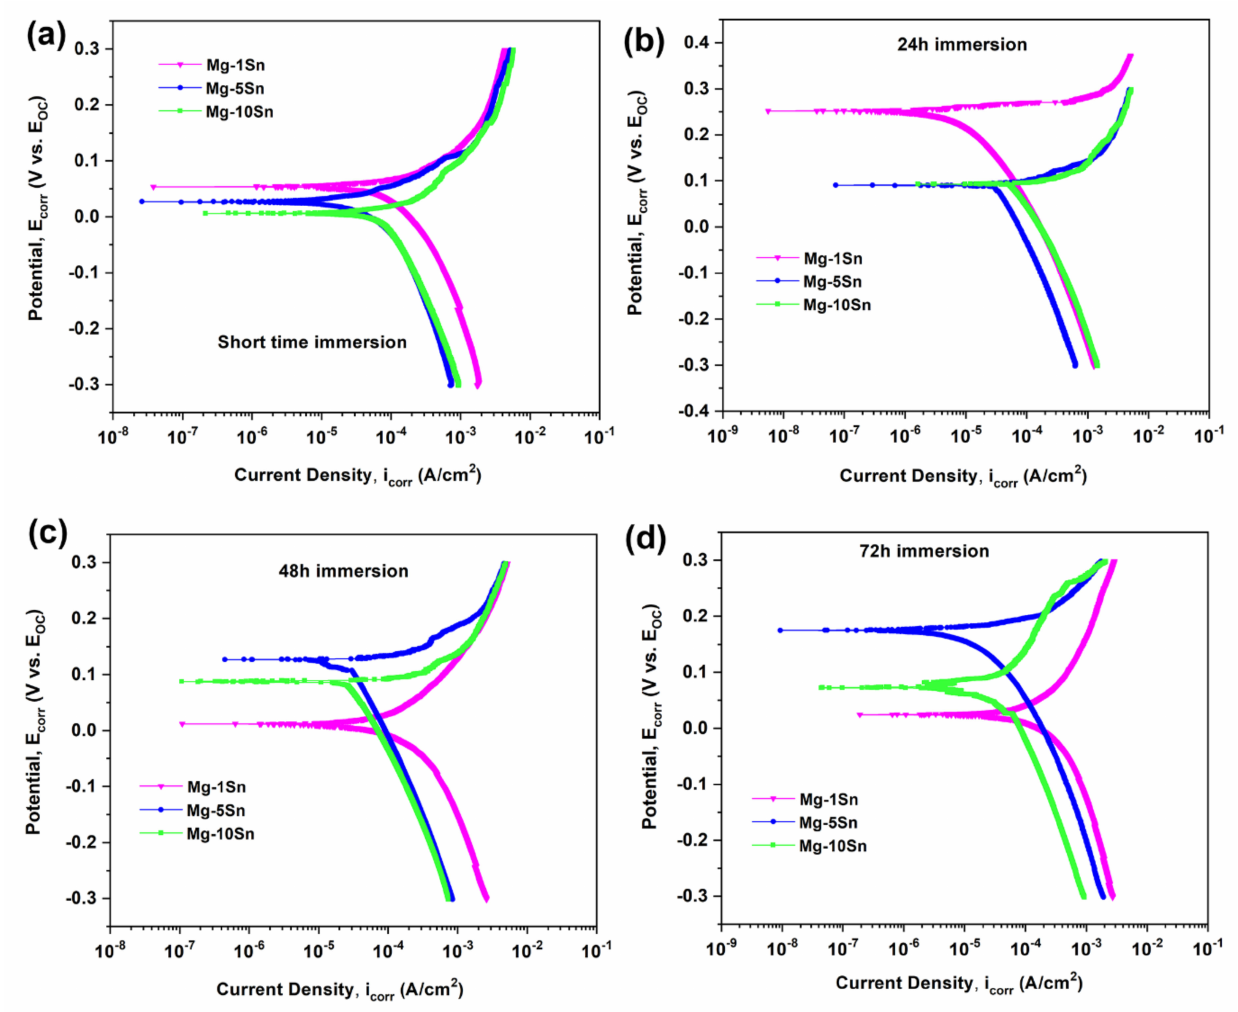
Figure 5. Tafel curves of Mg-Sn alloys under different immersion period. ( a ) ST ( b ) 24 h ( c ) 48 h ( d ) 72